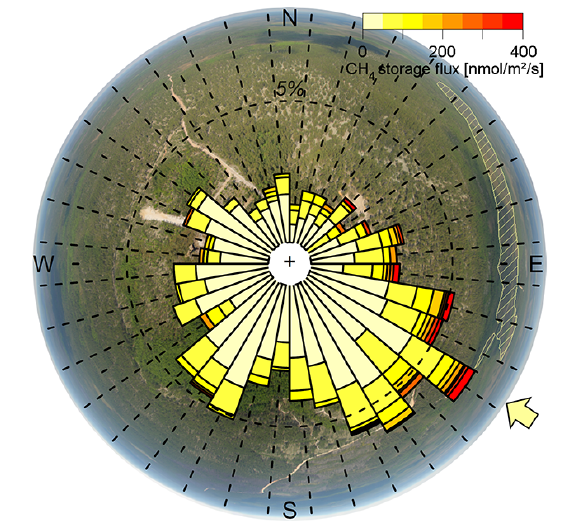
Fig. 11. Top view of ZOTTO centered on the tower with over- laid nighttime storage flux estimates (23:00 to 08:00KRAT; > 30nmol(m 2 s) − 1 only) vs. wind direction for all summer months June–September of 2009–2011: the overall lengths of the petals show how often a flux from this direction is measured, the arrow indicates the direction of the power generator, and the hatched area marks the closest